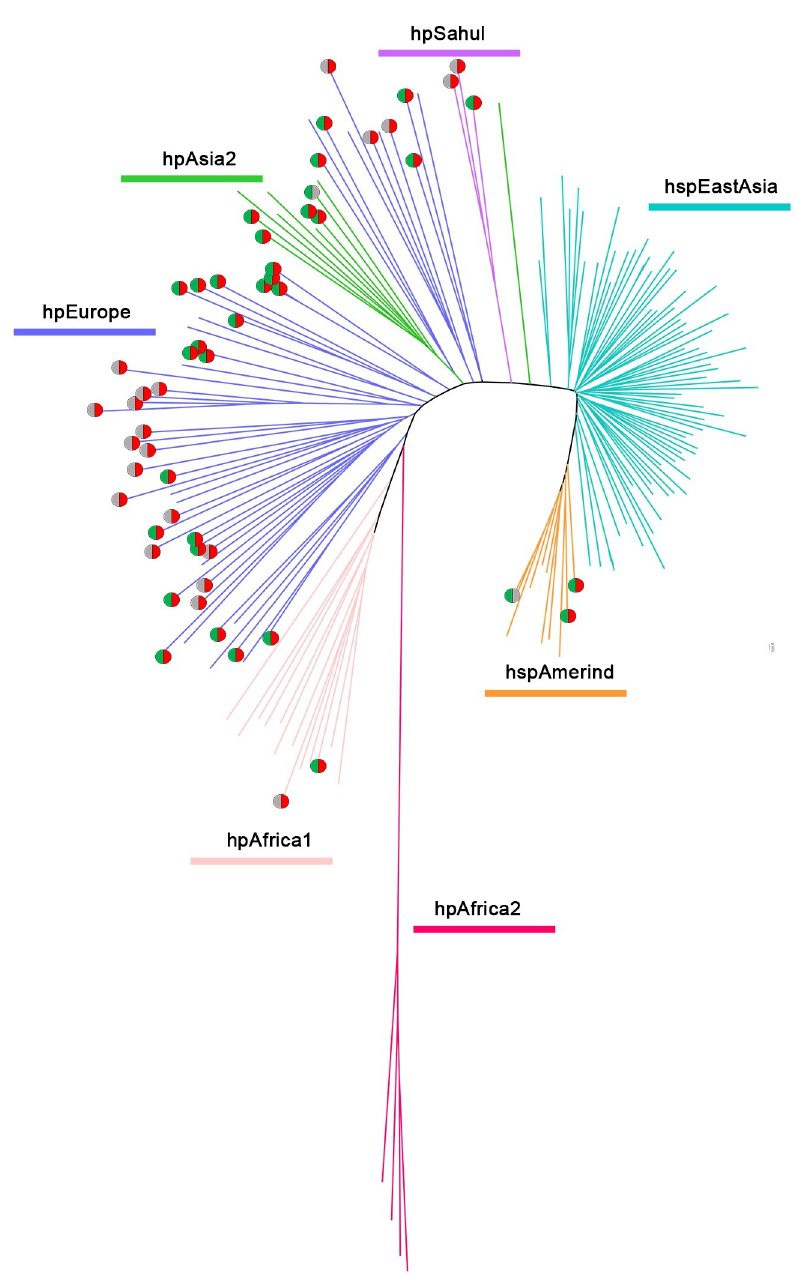
Fig 5. Phylogeographic distribution of the HP1283/HP1578 genes in 177 H . pylori strains. The population and subpopulation of the 177 strains were assigned by population structure analysis based on Bayesian approach [49]. The presence of HP1283 is coded by red, the presence of HP1578 is coded green, whereas their absence is coded gray.